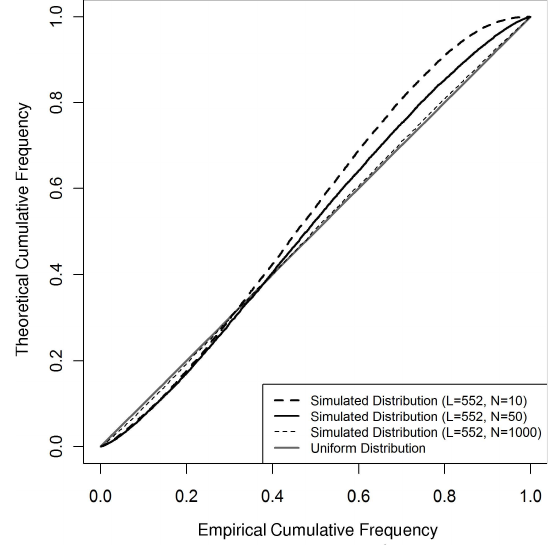
Fig. 3. FF distribution provided by simulation with random sam- ples extracted from an exponential distribution. Different curves represent three kinds of simulations with samples of different